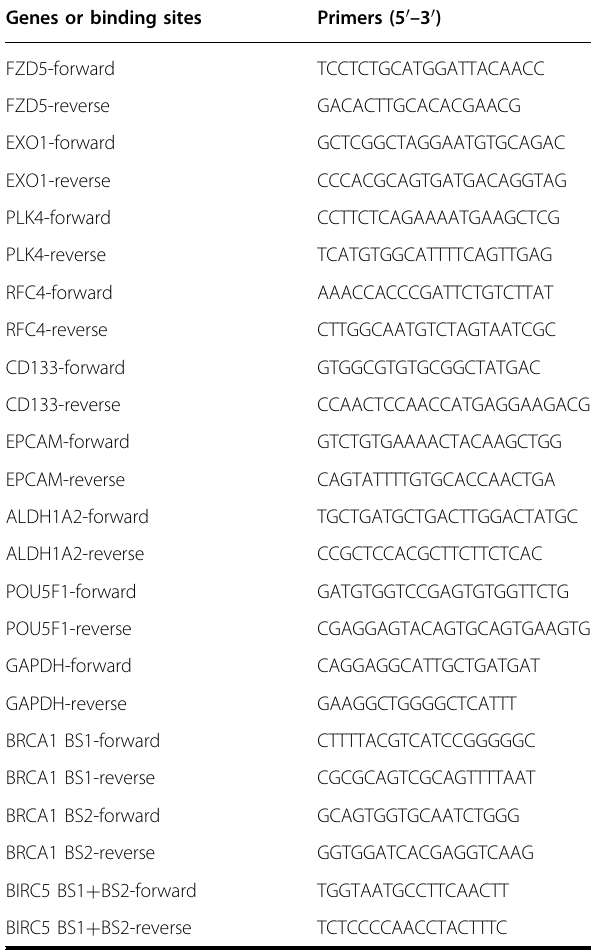
Table 1 Primers for real-time